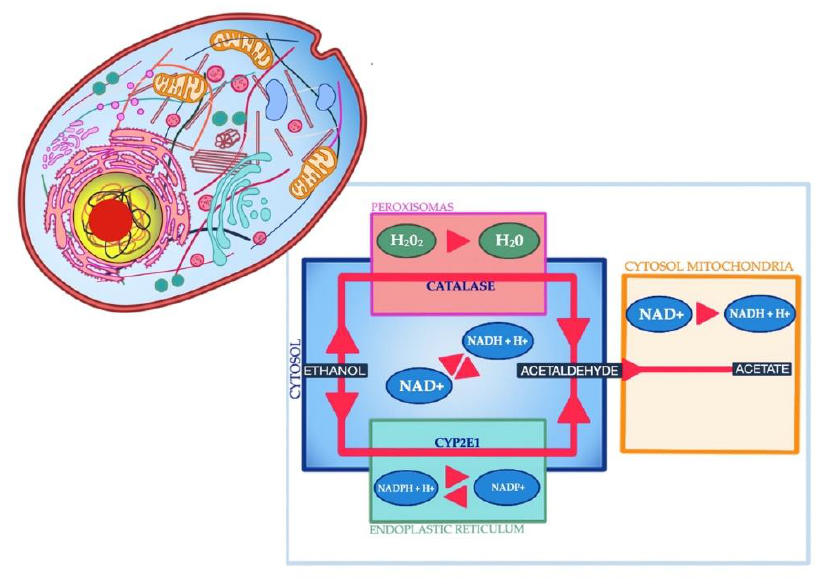
Figure 1. Three pathways of alcohol metabolism.